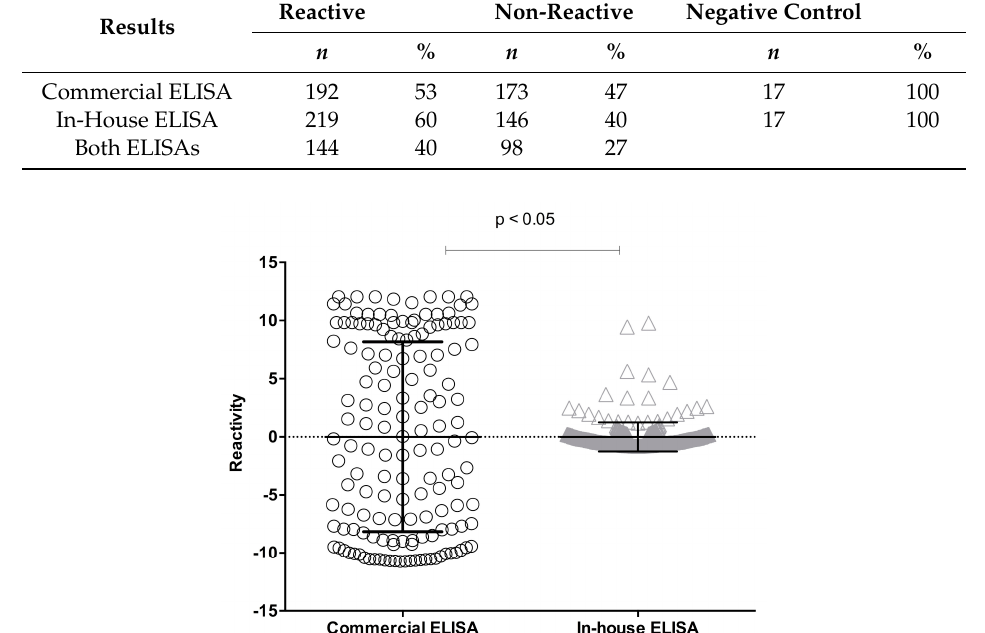
Figure 1. Serological reactivity of in-house and commercial Enzyme-Linked Immunosorbent Assays (ELISAs). Serum samples were evaluated by commercial ELISA incorporating recombinant antigens of P. vivax , P. falciparum , P. malariae , and P. ovalae ; and by in-house ELISA ( P. falciparum crude extract). Sera of individuals exposed to Plasmodium sp. ( n = 365) and not exposed to the parasite (negative control, NC n = 17) were evaluated in parallel by the two ELISAs. The results were analyzed by Student’s t -test and have been represented by scatter dot plot, medians, and interquartile ranges. Green line represents cut-off. Table 1. Comparative analysis and concordance between commercial and in-house ELISAs.